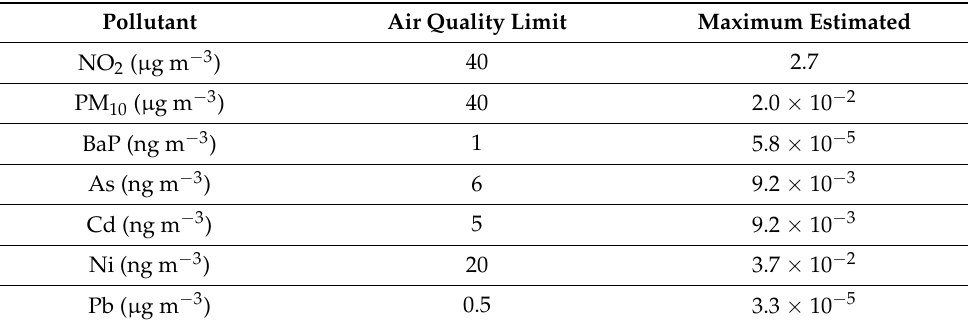
Table 4. Annual mean concentrations: air quality limits (EU Directive 2008/50/EC) [27] and maxi- mum estimated values in the modelling domain as WtE plant contribution. Pollutant Air Quality Limit Maximum Estimated NO 2 ( µ g m − 3